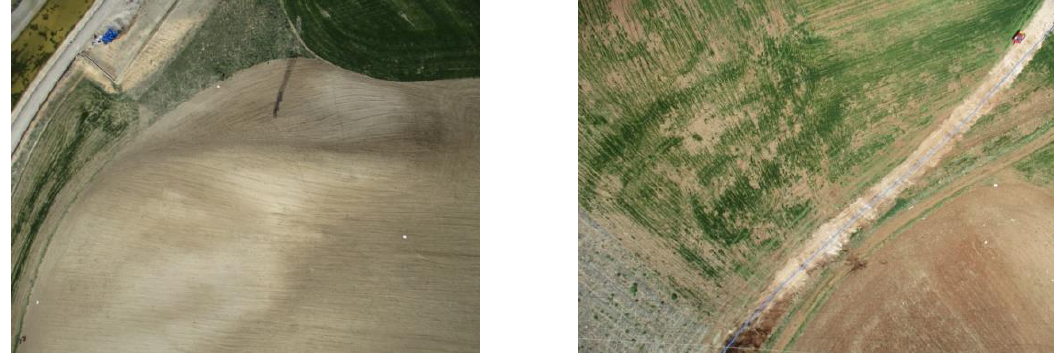
Figure 5. Air photo samples obtained by